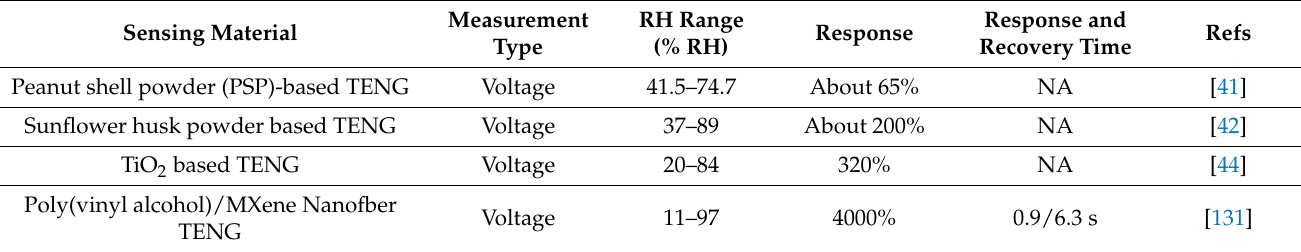
Table 8. The comparison of TENG humidity nanosensors.